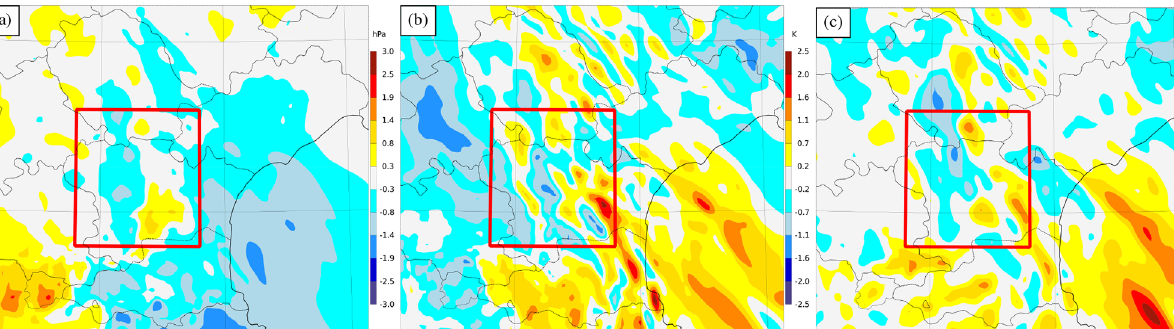
then moved slowly east–north-eastwards between 03:00 and 06:00 UTC (Fig. 11c,